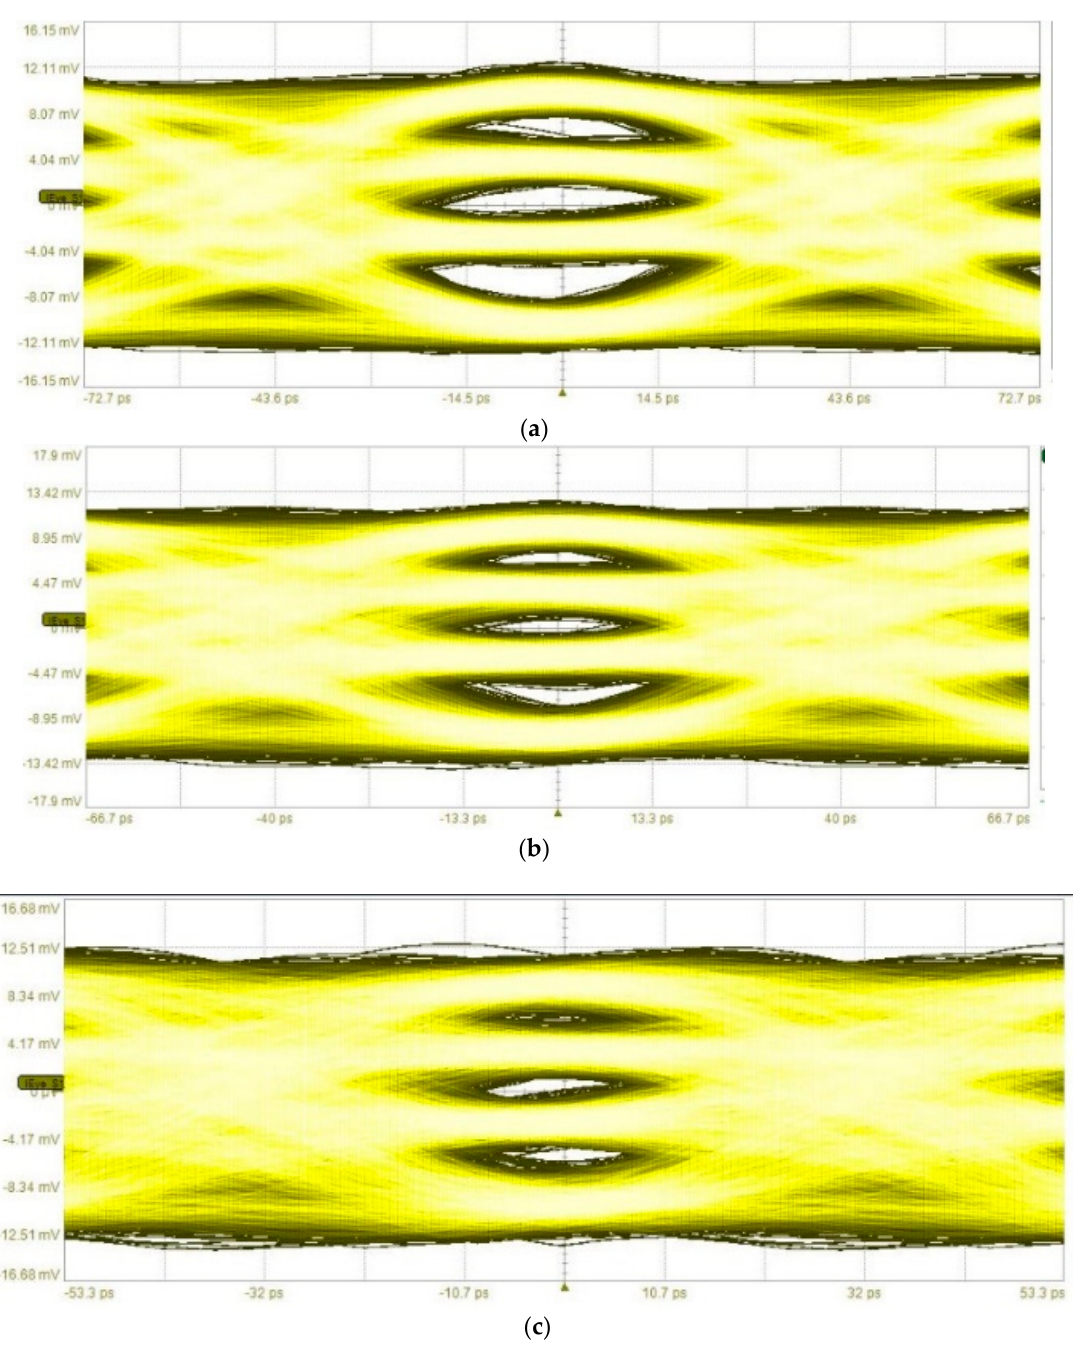
Figure 17. Eye diagrams from the demodulated PAM-2 signal at 130.6 GHz. ( a ) 30 Gbps signal. BER < ×10 − 12 . ( b ) 32 Gbps signal. BER = 2.6 × 10 − 10 .